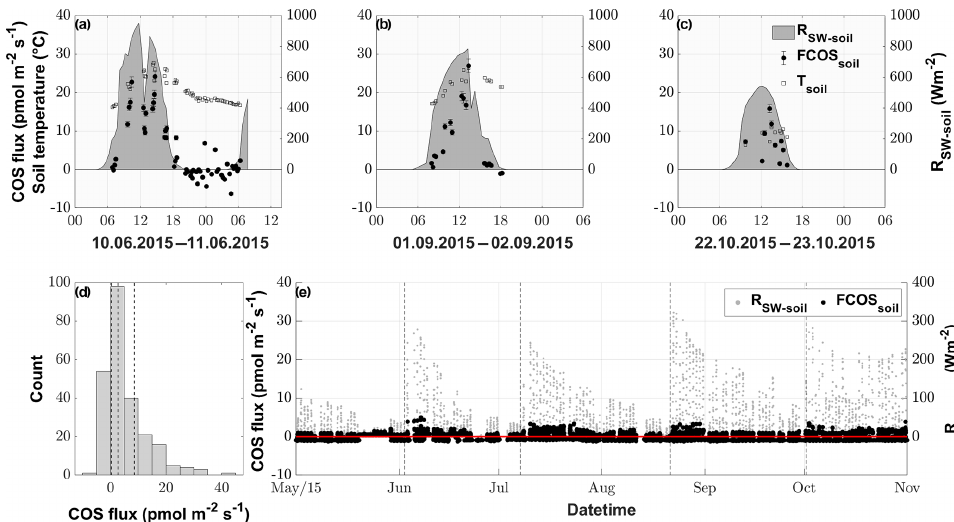
Figure 4. COS soil fluxes (pmolm − 2 s − 1 ) originating from manual chamber measurements of 3 selected days, (a) , (b) and (c) , depicted by black circles; incident shortwave radiation reaching the soil ( R SW − soil ), depicted by the gray area; and soil temperature ( T soil ), depicted by empty black bordered squares. (d) Histogram of all conducted COS soil chamber observations, with the dashed vertical lines depicting the 25%, 50% and 75% quantiles. (e) Season plot of the modeled COS soil fluxes ( F COSsoil ), depicted by the black circles; incident shortwave radiation reaching the soil surface ( R SW − soil ), depicted by gray circles; and the black dashed lines depicting the cuttings of the grassland.